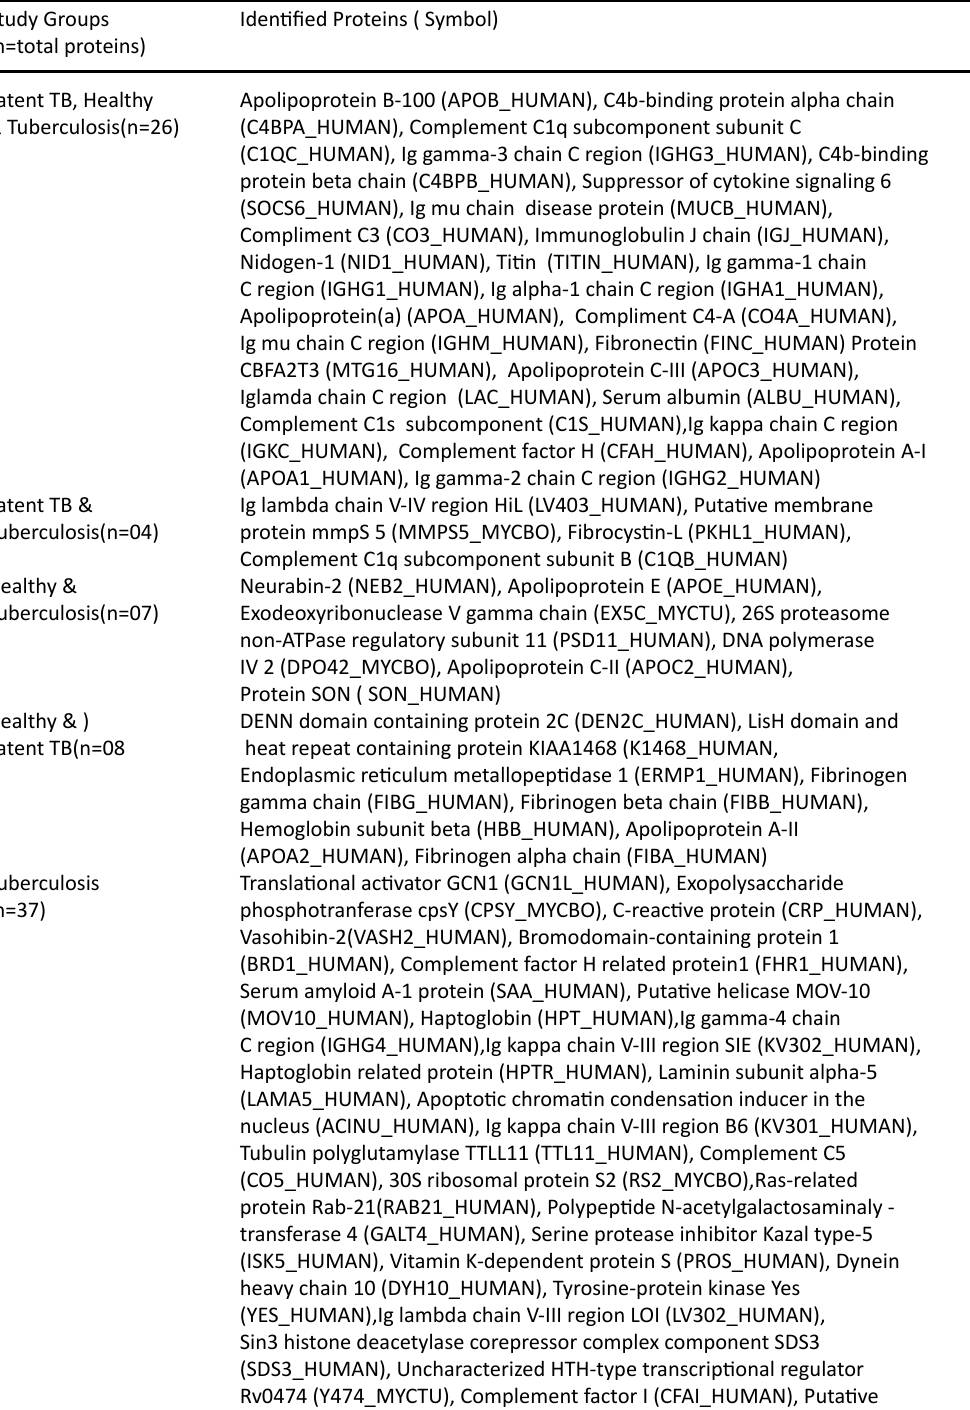
table 2. Detailed Descriptions of Identified Proteins in Different Study Groups. Study